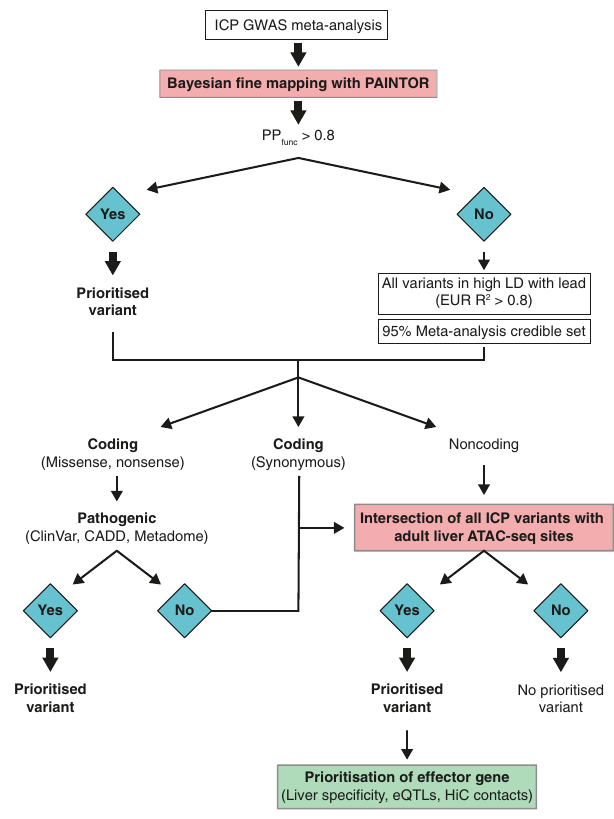
Fig. 2 Flowchart describing the variant prioritization strategy followed for the eleven loci reaching genome-wide signi fi cance in the GWAS meta-analysis of ICP. Sequential steps used to prioritize the variants are shown with the different approaches for nonsynonymous, synonymous, and noncoding variants indicated.